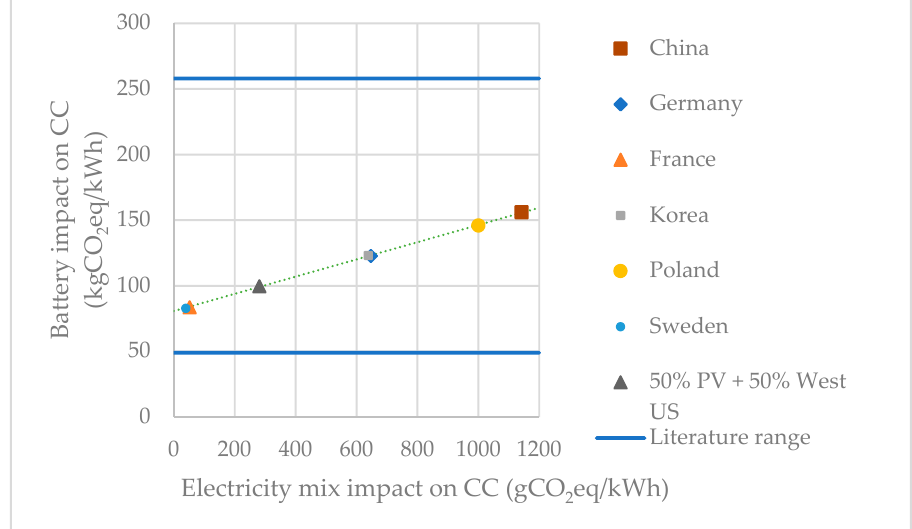
Figure 7. Greenhouse gas (GHG) emissions of a NCA pack manufactured in several countries.